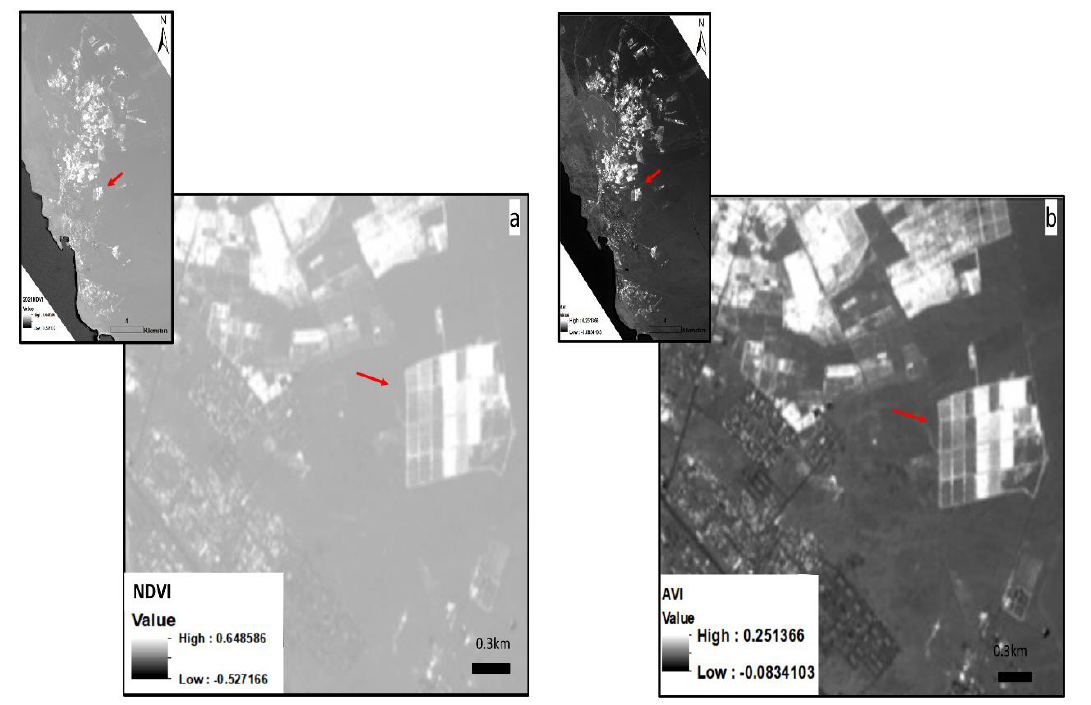
Figure 10. The difference between ( a ) NDVI and ( b ) AVI indices by applying both on Sentinel 2A data for 2021. The red arrow shows the farm that contains light, moderate, and heavy vegetation.